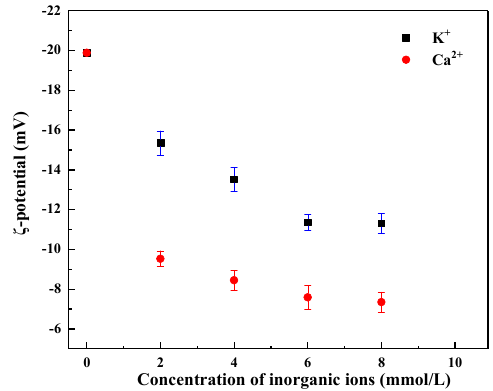
Figure 5. ζ -potential of coke powder in solutions with various concentrations of inorganic ions (the error bars represent the standard deviation obtained from measurements in